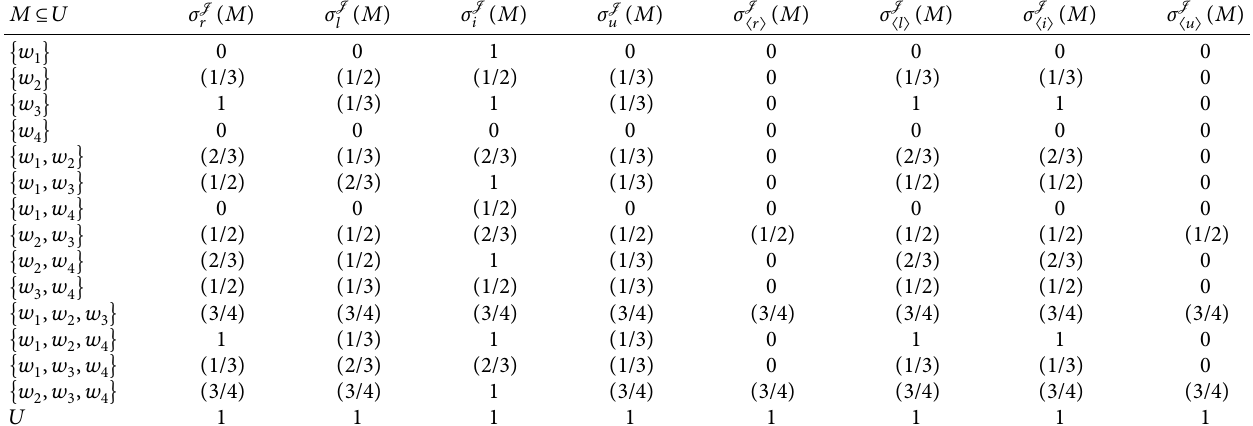
j ∈ r,l,i, u, 〈 r 〉 , 〈 l 〉 , 〈 i 〉 , 〈 u 〉{ } .